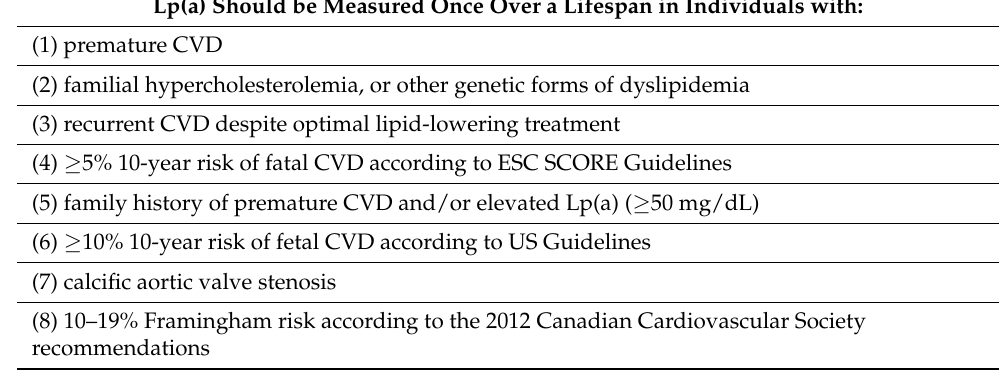
Table 2. Screening of